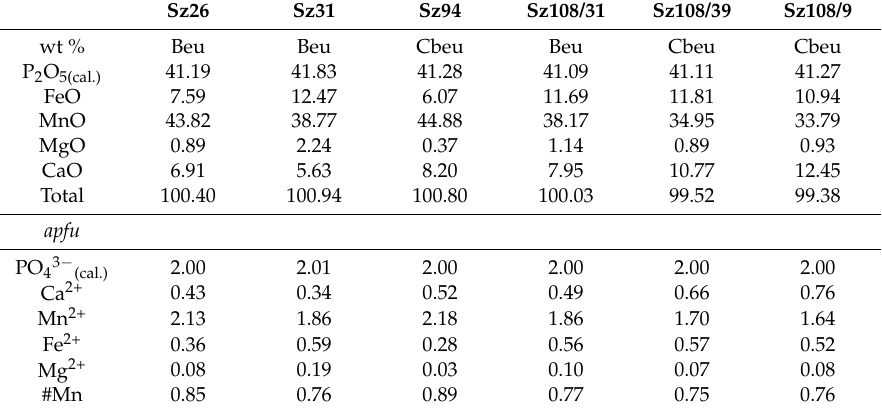
Table 4. Average compositions of beusites associated with Type 1 apatites from the Szklary pegmatite. The compositions of beusite-(Ca) from Sz108 sample due to its heterogeneity are presented as selected representative analyses. Abbreviations: Sz26/35 = sample/analysis, Beu—beusite, Cbeu—beusite-(Ca), #Mn = Mn/(Mn +